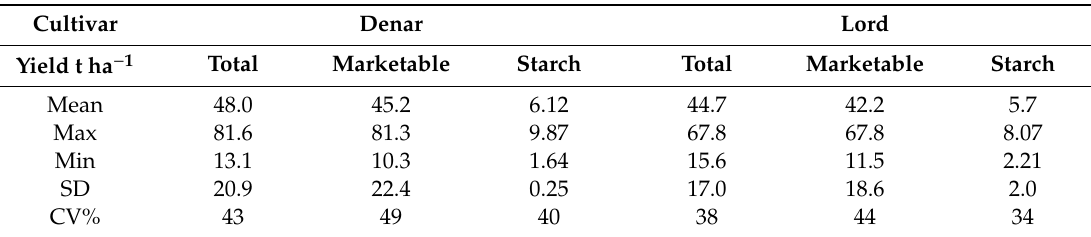
Table 3. Statistical characterization of the fresh tuber yield (t ha − 1 ) of Lord and Denar potatoes (average from all